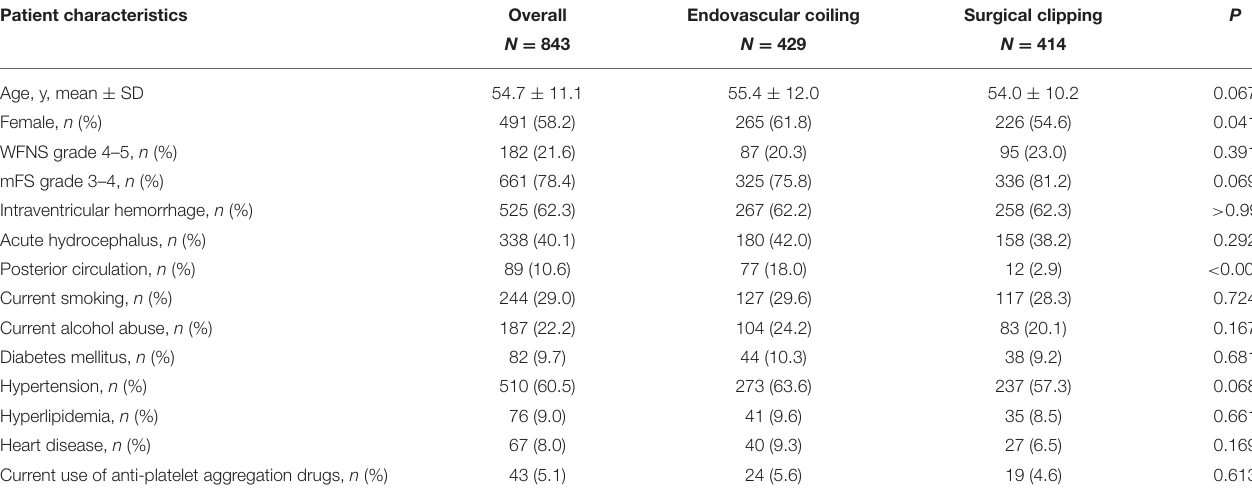
TABLE 1 | Baseline characteristics and group comparisons between the two treatment modalities.